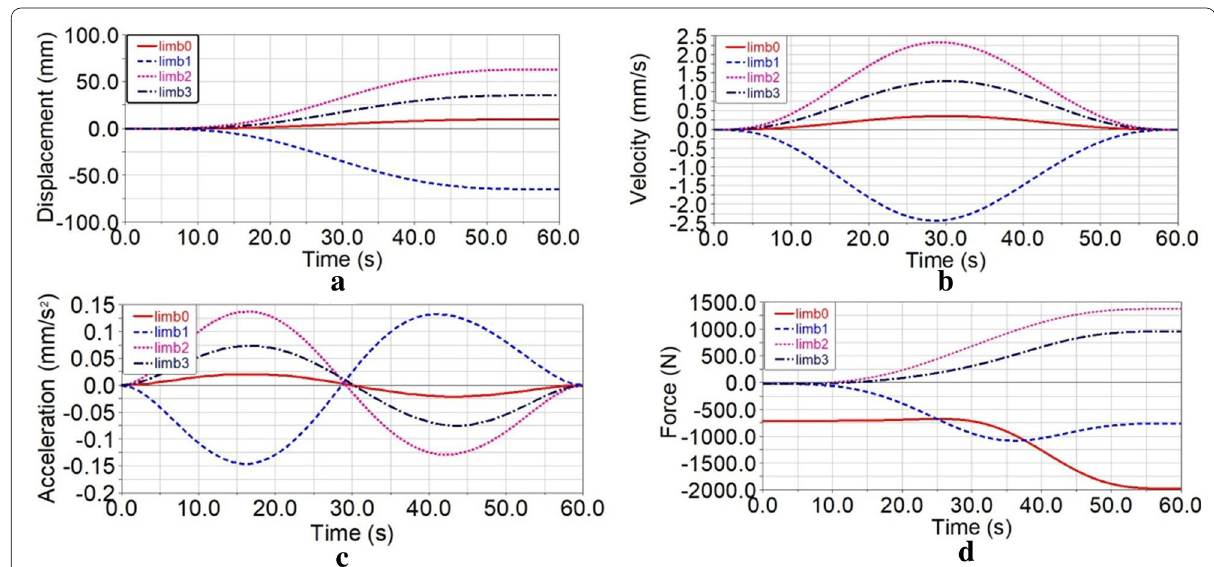
Figure 10 a Displacement, b velocity, c acceleration, and d driving force of each limb of module 3